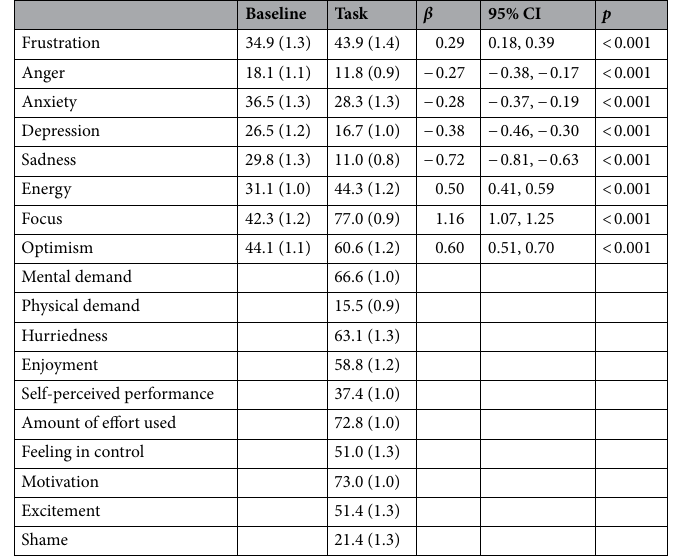
Table 2. Mean ratings (SEM) at baseline and during the Frustration Tolerance Task (rated immediately after the task, indicated as Task). Standardised coefficient estimates (β), 95% confidence intervals (CI), and p values are shown for task effects (baseline, task) for all mood variables. Higher scores (maximum of 100) indicate a greater level of the variable (e.g., higher anxiety, higher energy, greater effort